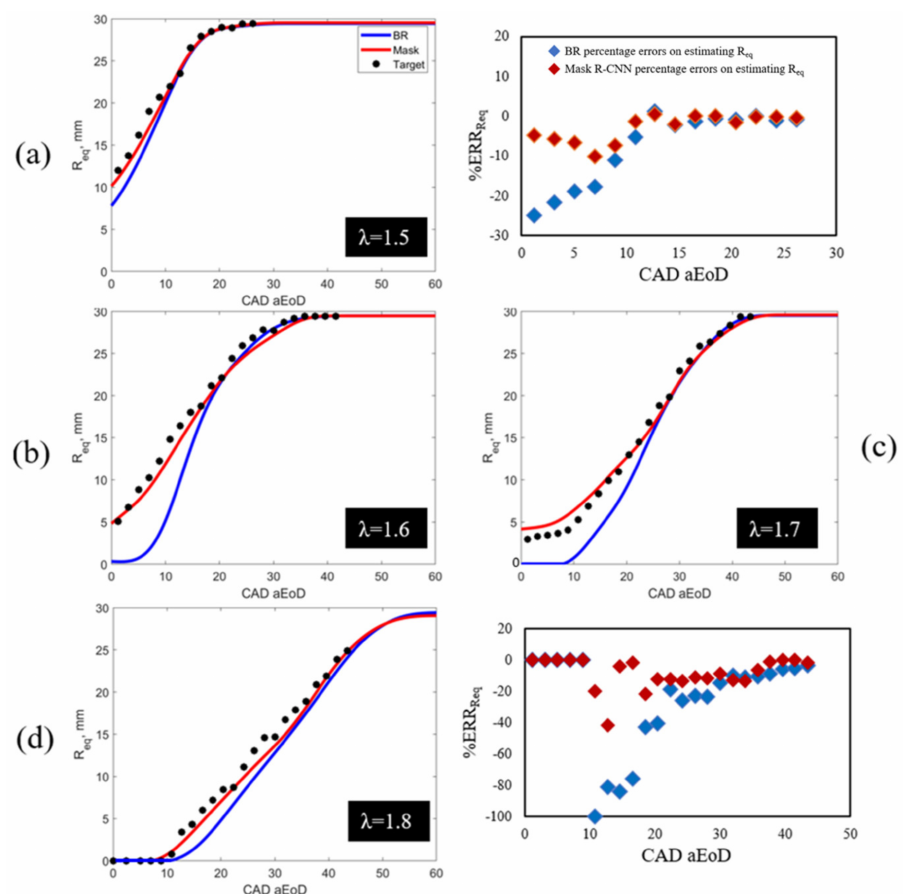
Figure 8. Equivalent flame radius at different λ ( a – d ) produced by BR (blue curve) and Mask R-CNN (red curve) to be compared with the Target (black round markers). The error in evaluation in the equivalent flame radius is intentionally reported, at λ = 1.5 and λ = 1.8, without the absolute value to better distinguish overestimations and underestimations produced by the compared